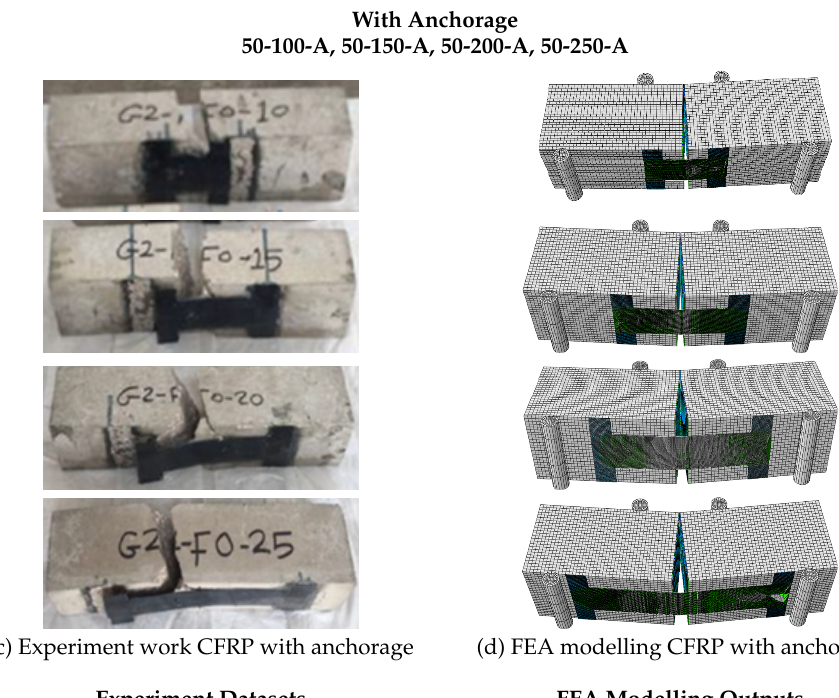
Fig. 14. Consistency crack patterns and failure mode with experiment